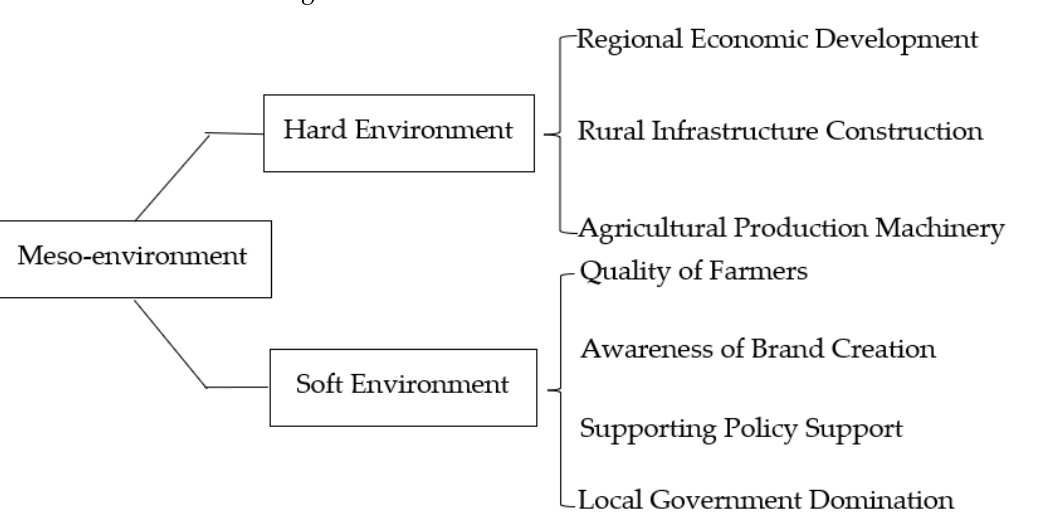
Figure 1. Brand-driven